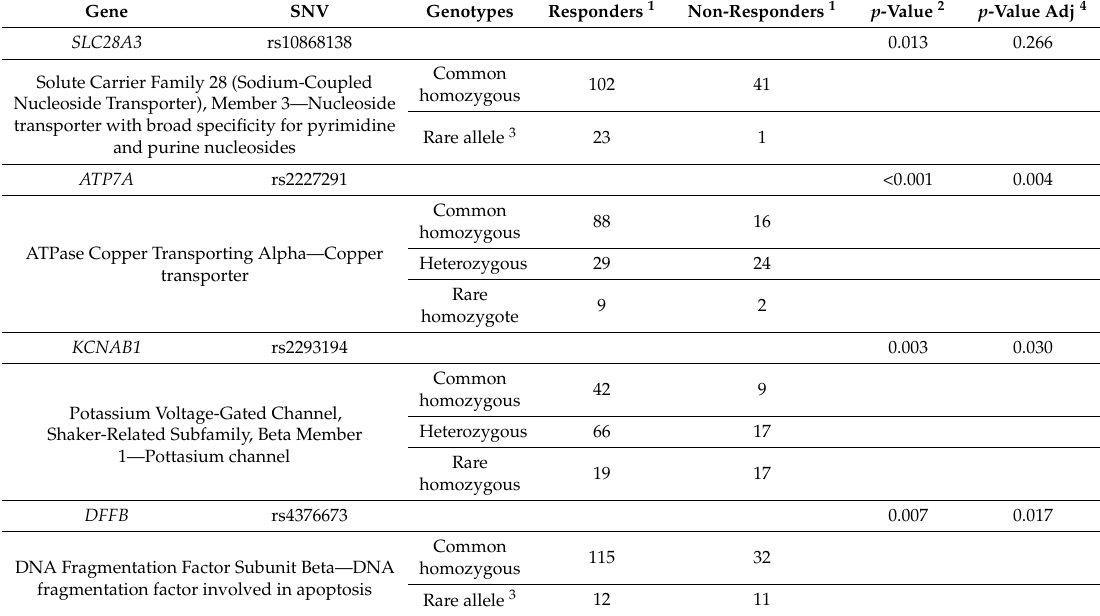
Table 8. Validated variants significantly associating with the response of patients to neoadjuvant cytotoxic therapy in the validation